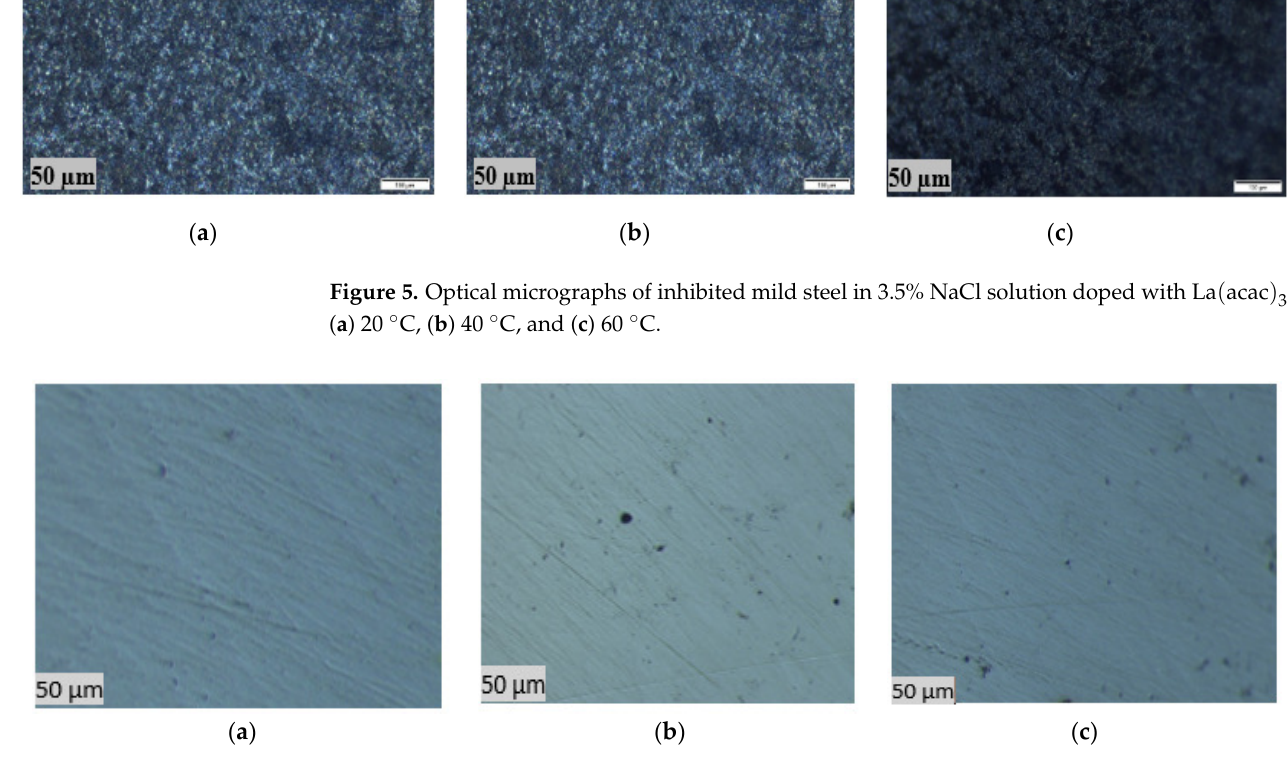
Figure 6. Optical micrographs of inhibited 304 SS in 3.5% NaCl solution doped with Ce ( hfac ) at ( a ) 20 ◦ C, ( b ) 40 ◦ C, and ( c ) 60 ◦